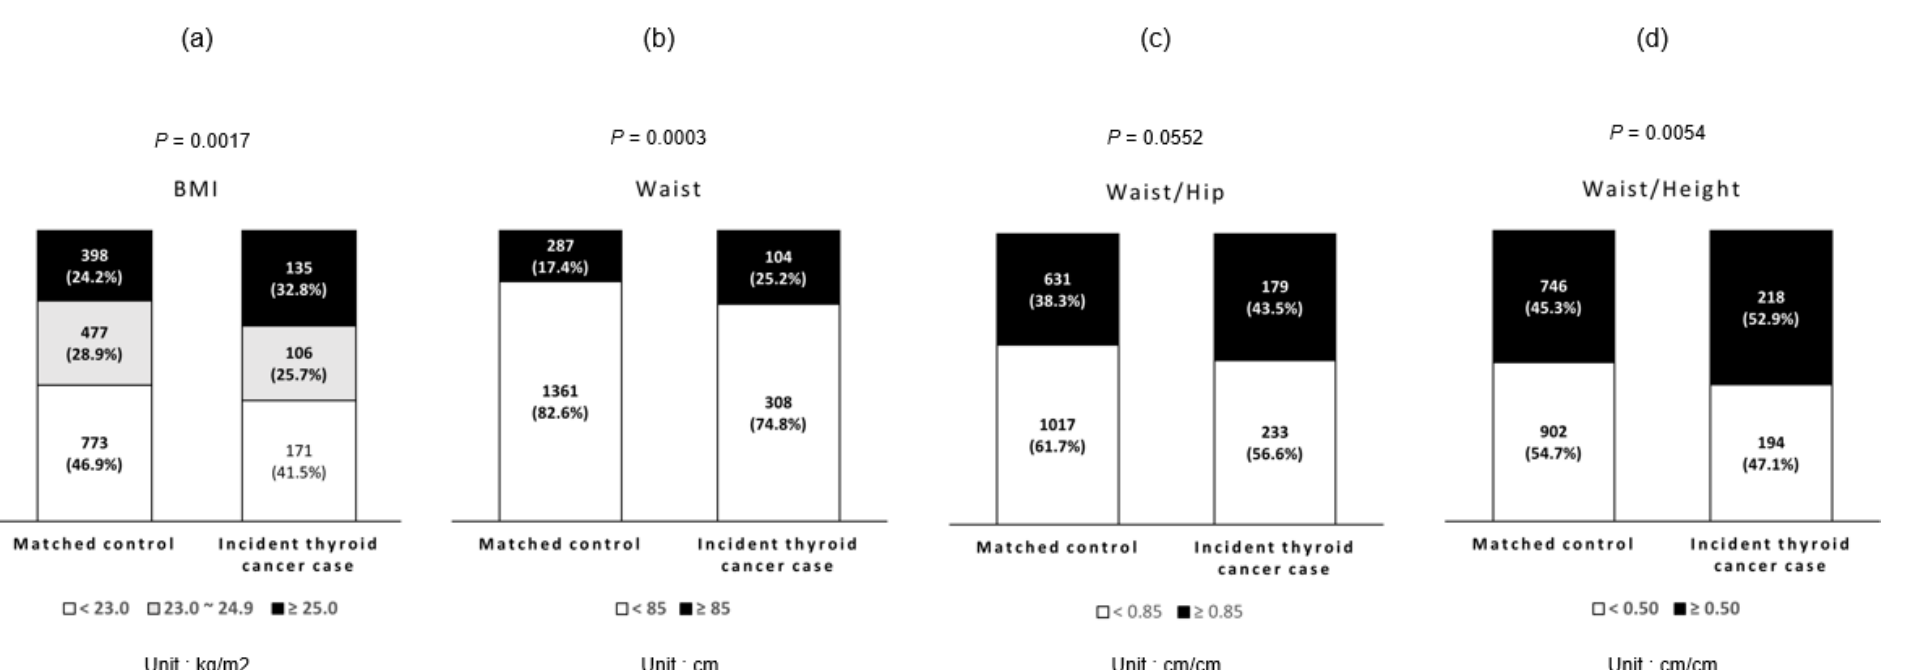
Figure 2. Prevalence of obesity in baseline measurements. ( a ) The proportions of obesity in terms of BMI. ( b ) The proportions of obesity in terms of WC. ( c ) The proportions of obesity in terms of WHR. ( d ) The proportions of obesity in terms of WHTR. BMI was classified into obese ( ≥ 25.0 Kg/m 2 ), overweight (23.0–24.9 Kg/mm 2 ), and normal (<23.0 Kg/mm 2 ). Participants with WC ≥ 85 cm, WHR ≥ 0.85, and WHTR ≥ 0.5 were considered obese, and participants with WC < 85, WHT < 0.85, and WHTR < 0.5 were considered normal. p -Values were estimated from chi-square test. The proportions of obesity in terms of BMI, WC, and WHTR in thyroid cancer cases were significantly higher than matched controls.